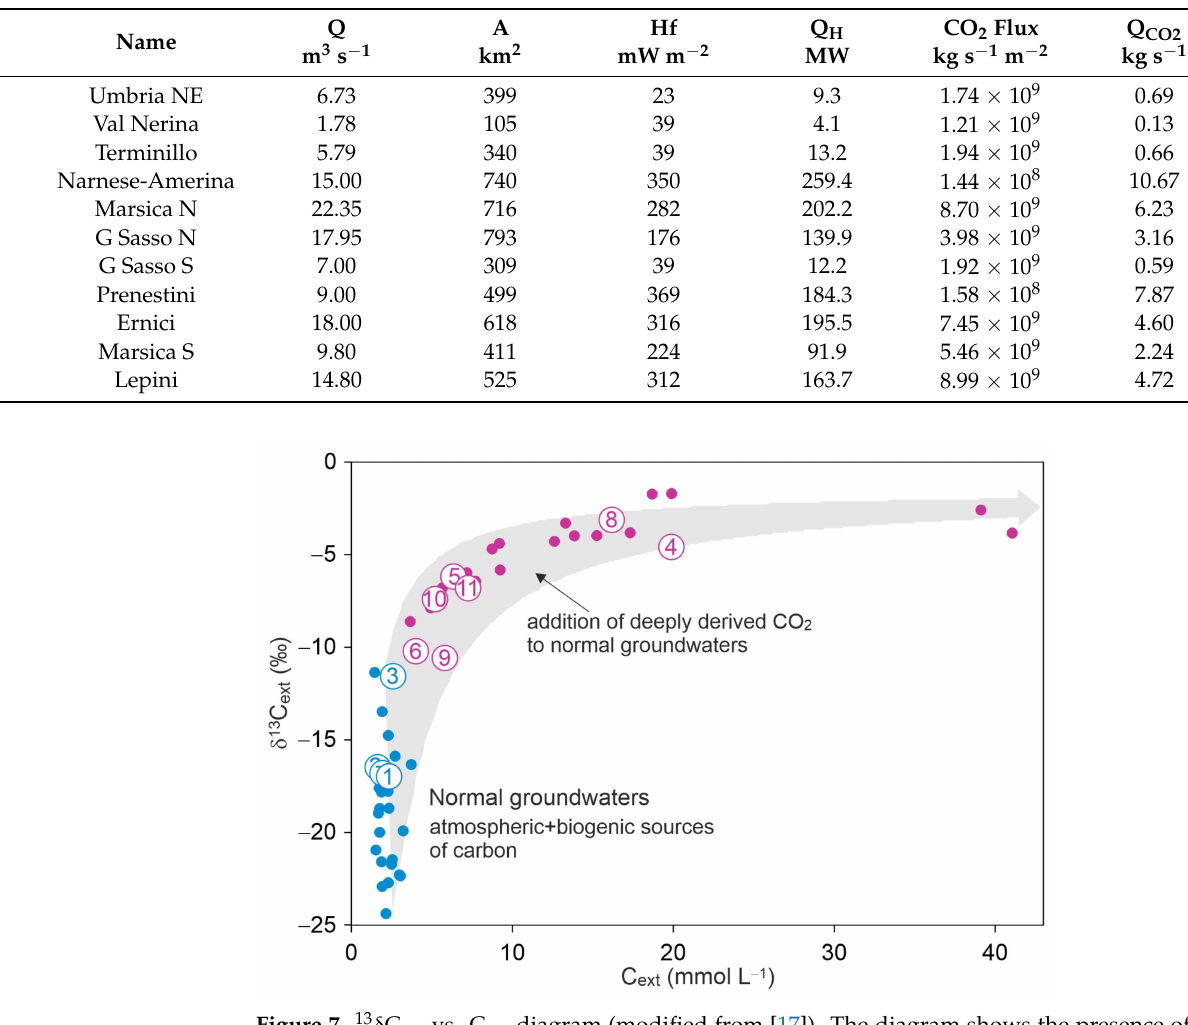
Figure 7. 13 δ C ext vs. C ext diagram (modified from [17]). The diagram shows the presence of two groups of water: the normal groundwater where the carbon derives from the atmospheric and biogenic CO 2 (blue points) and waters generated by the addition of deeply derived CO 2 to normal groundwaters (magenta point). In the figure are also reported the mean C ext and δ 13 C ext of the eleven investigated aquifers (open circles, numbers refer to Table 4). The grey band corresponds to the theoretical compositions computed by adding deep CO 2 with a δ 13 C = − 1.5‰ to the normal groundwaters (redrawn from